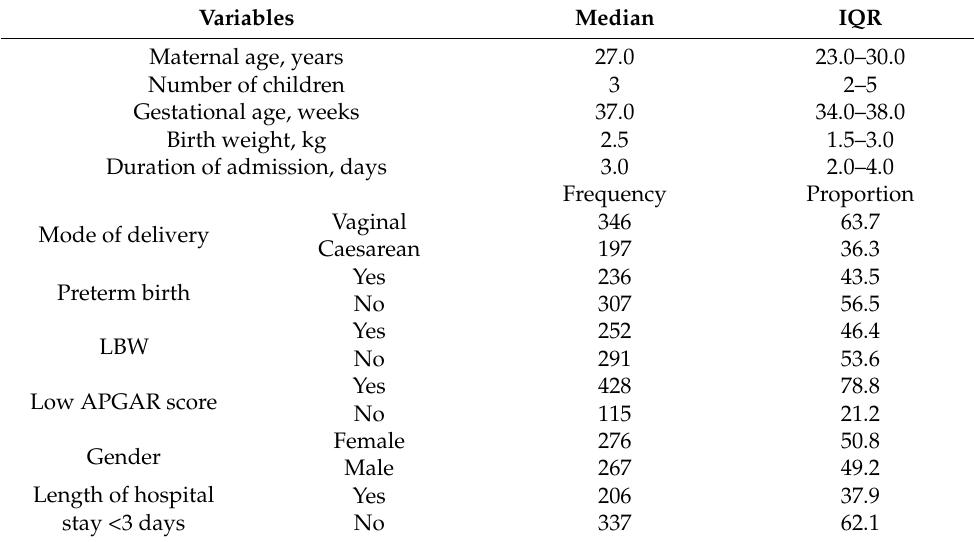
Table 1. Characteristics of newborns admitted to the NICU of Gadarif Hospital (N = 543).